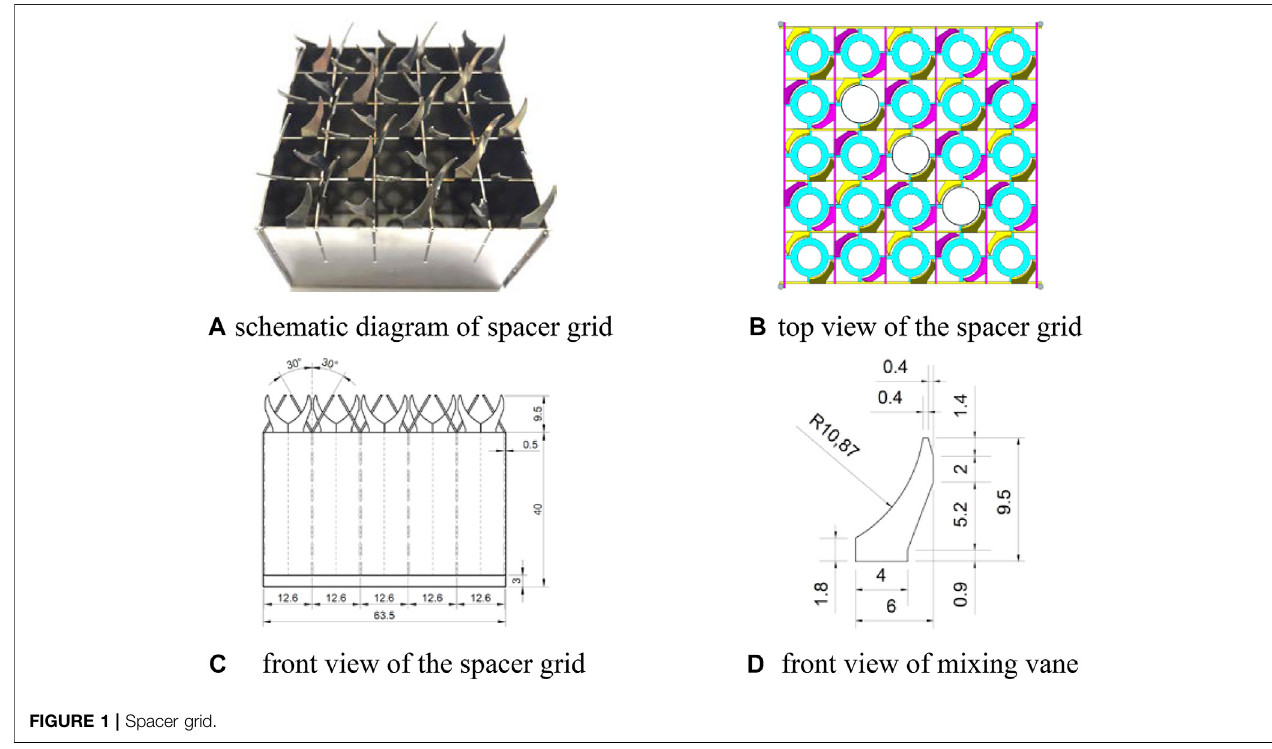
FIGURE 1 | Spacer grid.